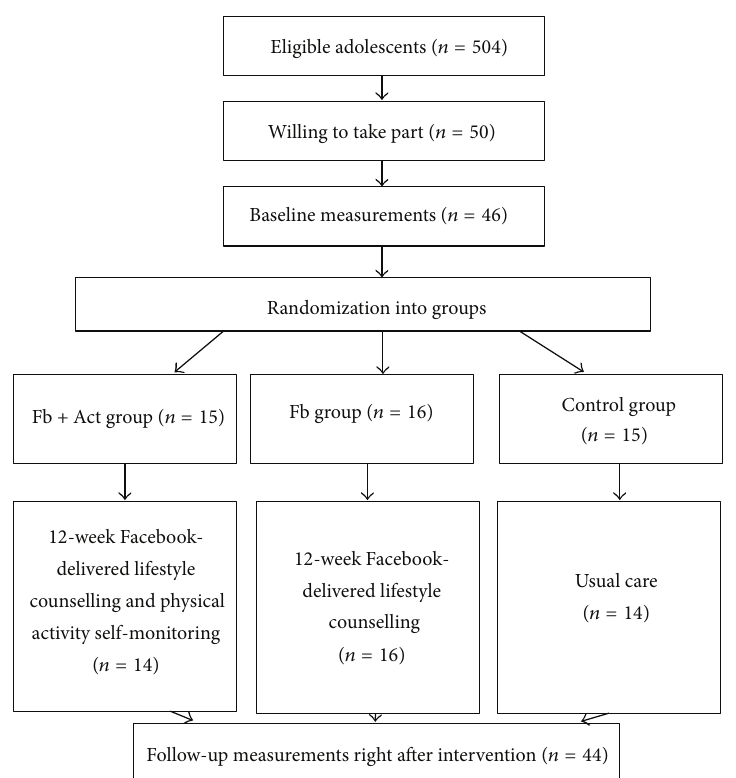
Figure 1: Flow of participants through the